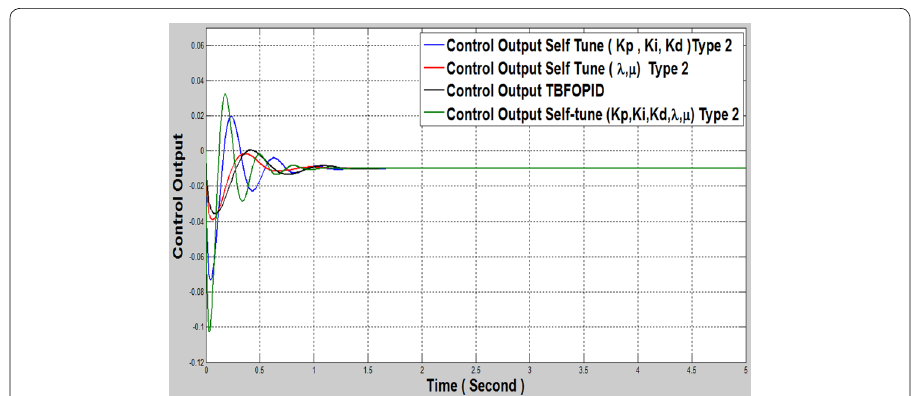
Fig. 27 Controller output via IT2FST ( k p , k i , k d , λ and μ )